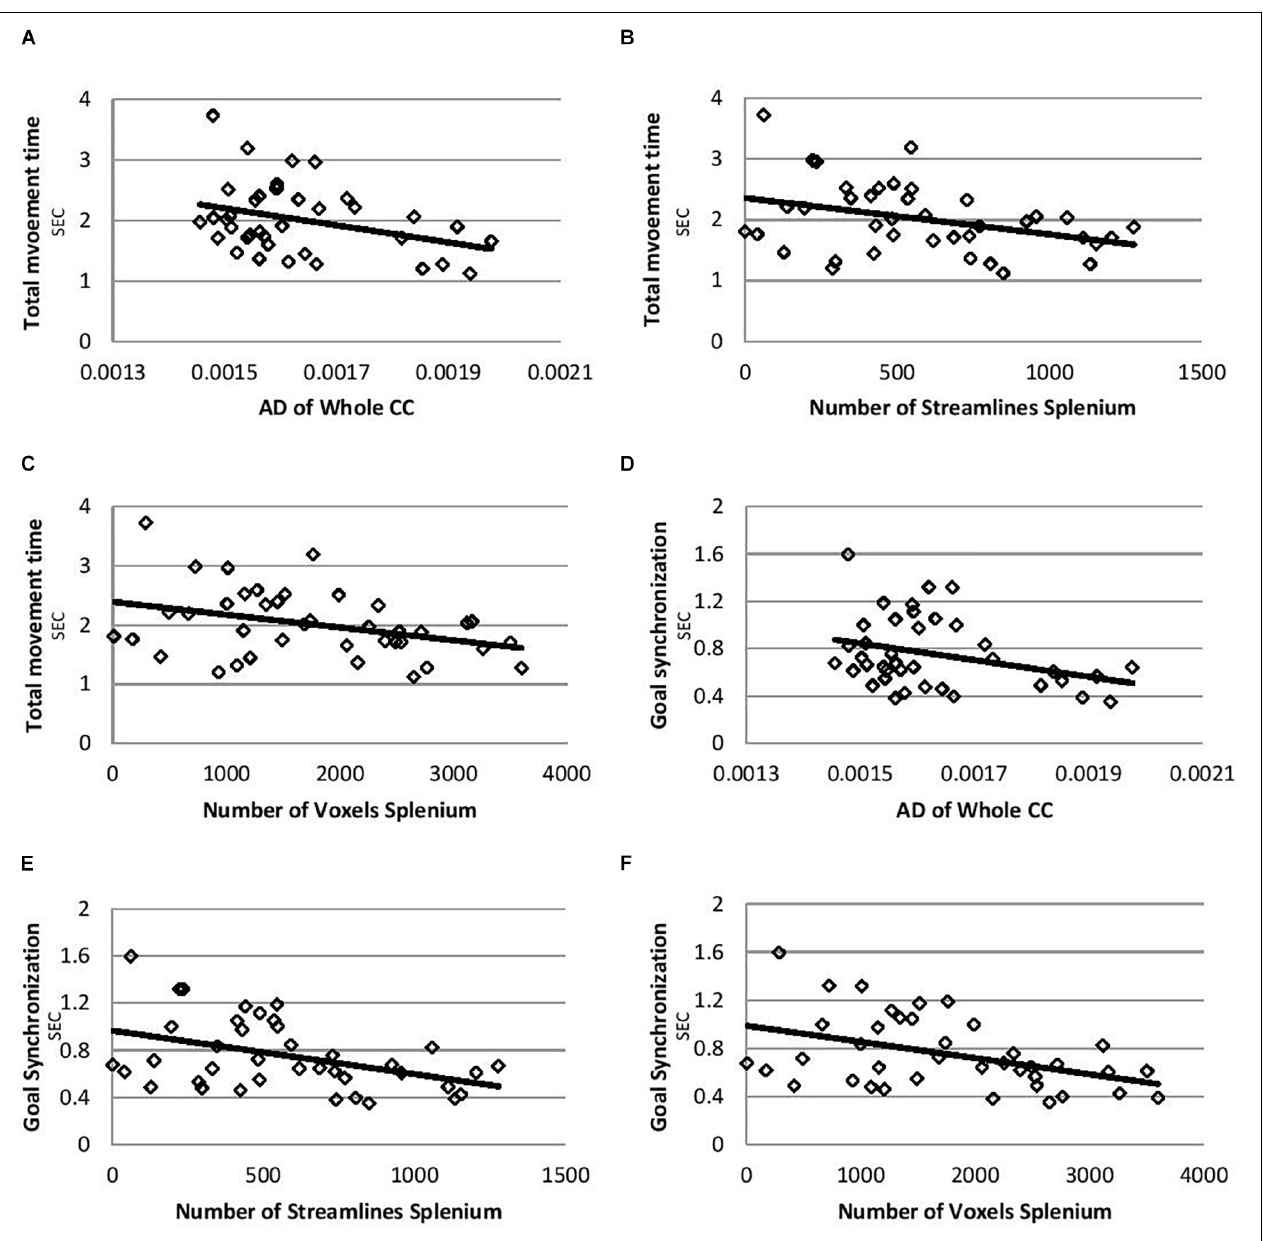
FIGURE 1 | Correlation plots for total movement time and goal synchronization. (A) Correlation between total movement time and AD of whole CC. (B) Correlation between total movement time and number of streamlines of splenium. (C) Correlation between total movement time and number of voxels of splenium. (D) Correlation between goal synchronization and AD of whole CC. (E) Correlation between goal synchronization and number of streamlines of splenium. (F) Correlation between goal synchronization and number of voxels of splenium. AD, axial diffusivity; CC, corpus